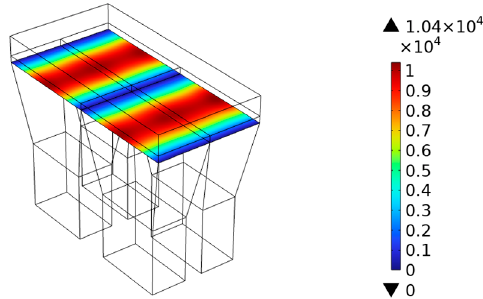
Figure 3. Electric field distribution in the cross-section of a horn antenna.